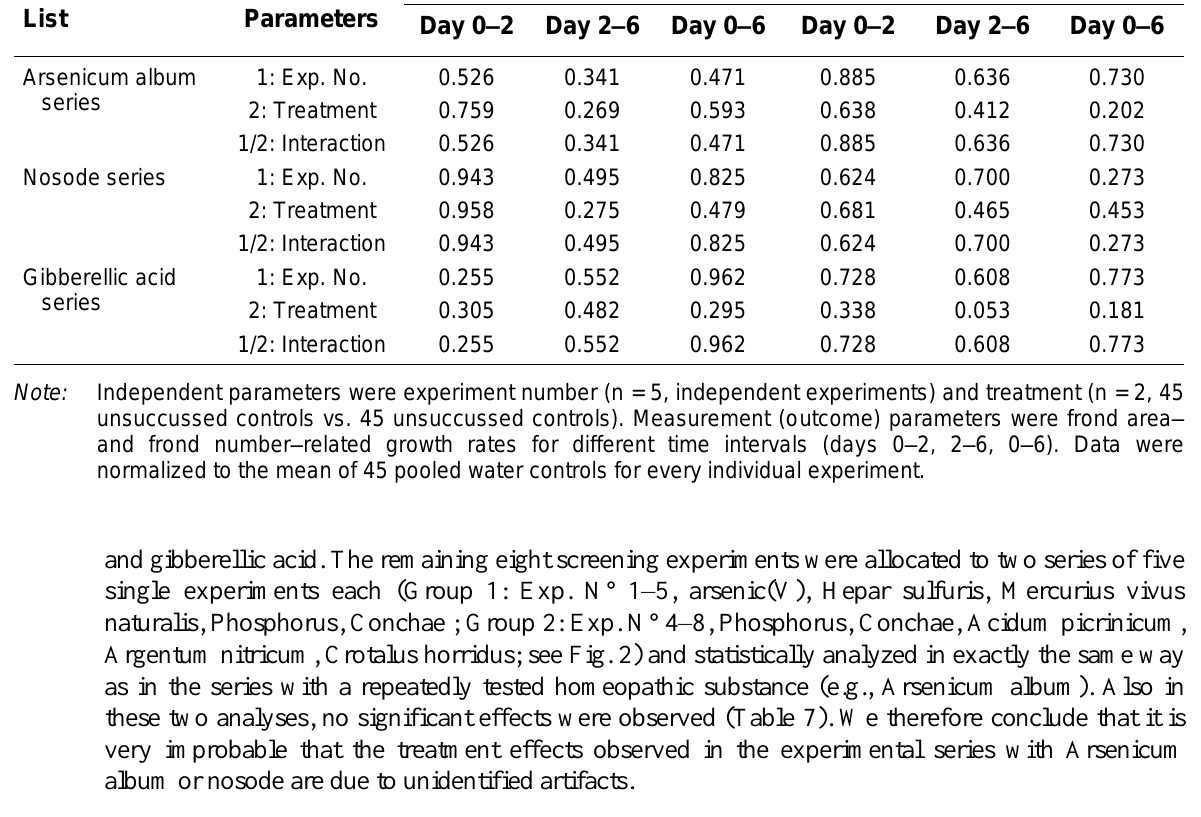
ANOVA Analysis of the Systematic Negative Control Experiments (SNC) with the Randomization Lists of the Verum Experimental Series (Arsenicum album, Nosode, and Gibberellic Acid)